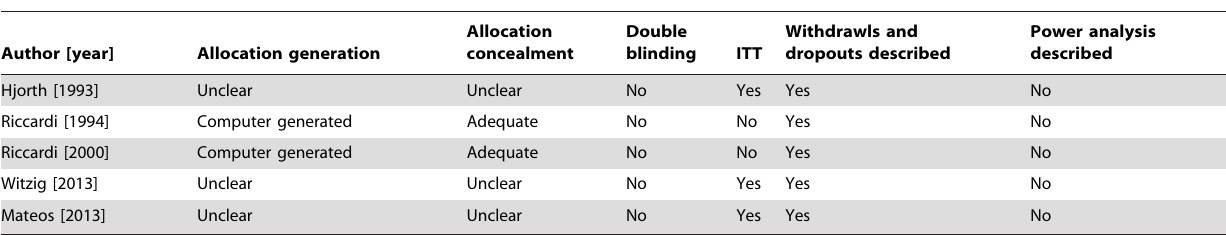
Table 2. Methodological quality assessment of included trial.